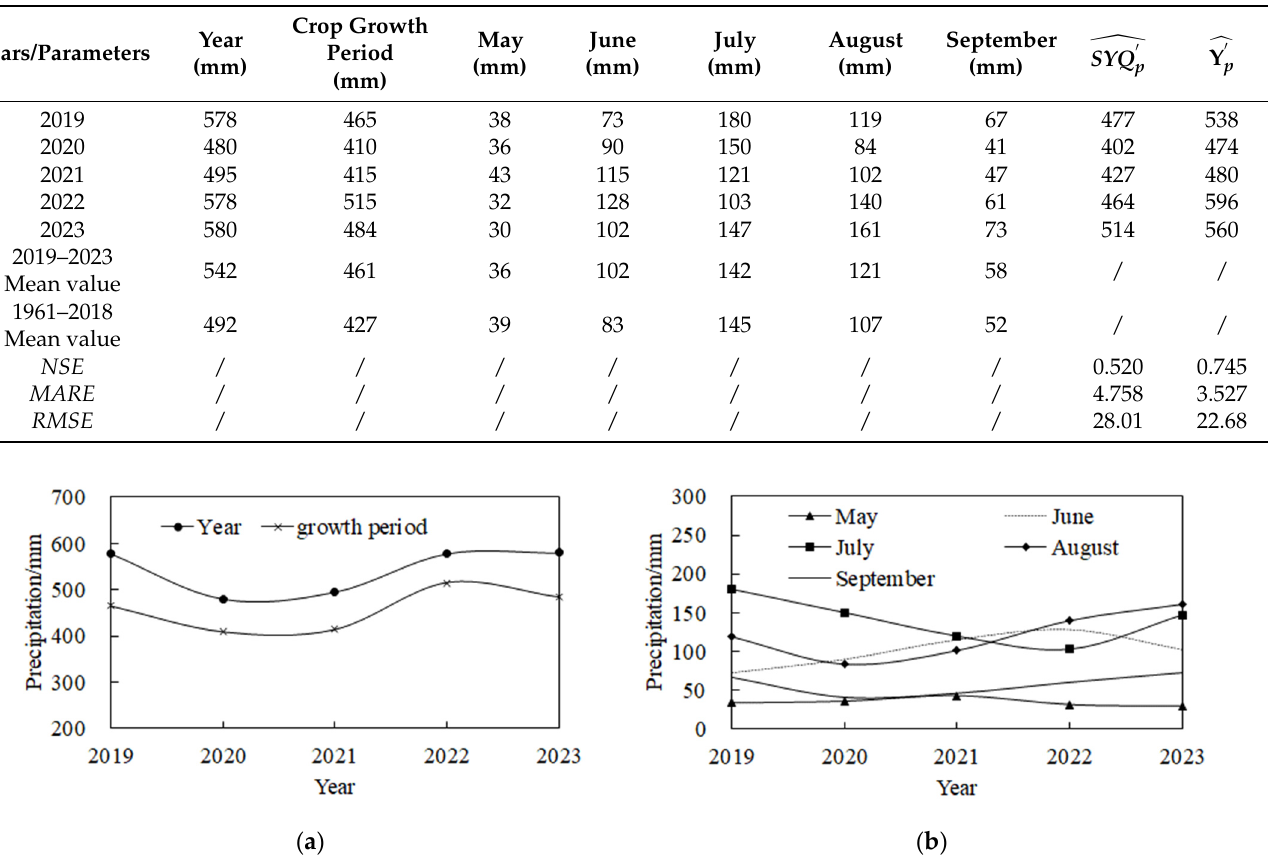
Figure 4. Forecasting results at different scales from 2019 to 2023. ( a ) Annual and crop growth period scales; ( b ) Monthly scale during the crop growth period.